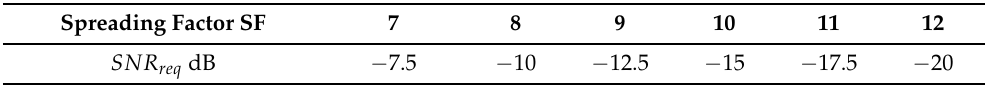
Table 4. Required SNR for each